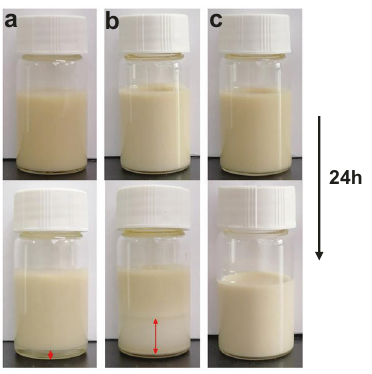
Fig. 4 | The stability of ZIF-8 slurries. State changes of ZIF-8 (30 wt%) slurry with differentliquidmediaover24h: a water, b solventDMPU, c solventDMPU(80wt%)+ water (20 wt%). Top: freshly prepared slurries; bottom: slurries after standing for 24